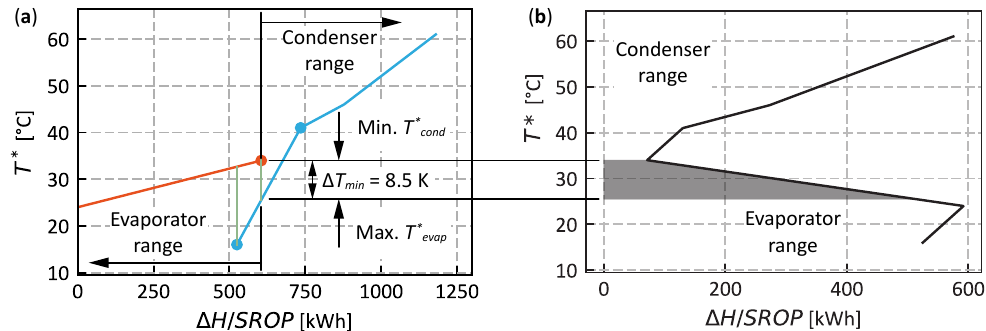
Figure 6. ( a ) ISSP of the demonstration case with IHR of 80 kWh. The enthalpy ranges of the evaporator and condenser are marked with the corresponding maximum evaporation and minimum condensation temperature. ( b ) Resulting adapted GCC, including restricted temperature